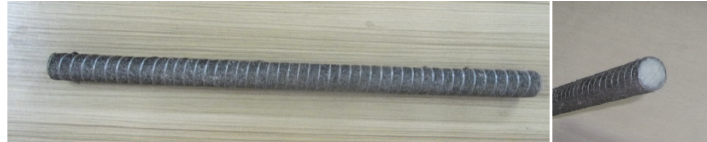
Figure 1: BGFRP bar specimen.